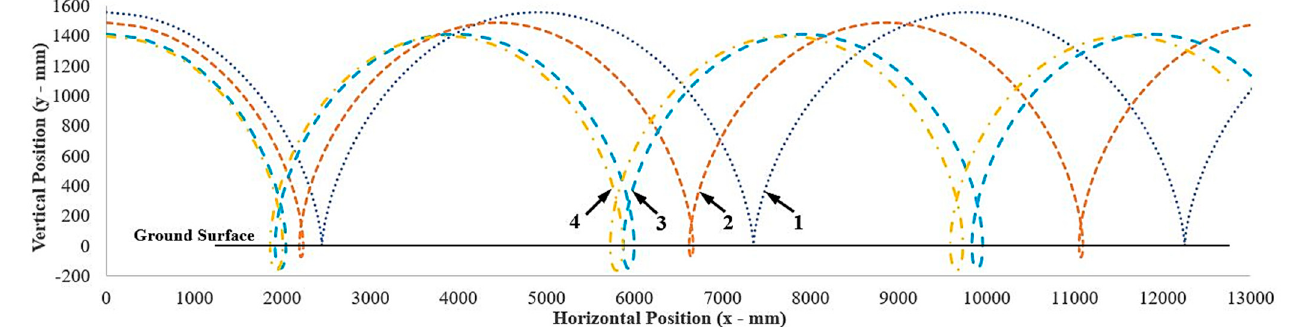
Figure 7. Motion trail or trajectories of point M at different lug penetration and wheel submergence, Corves 1, 2, 3 and 4 represent submergence of 0, 75, 150 and 165 respectively.